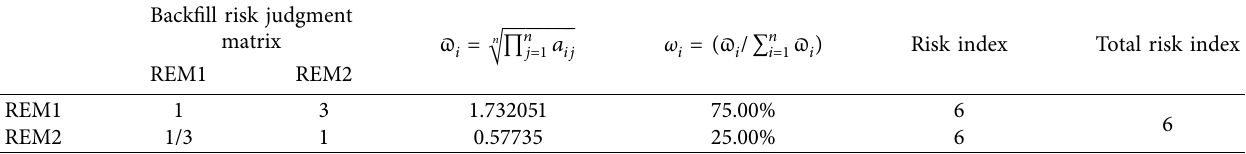
Table 32: Backfill risk judgment matrix.